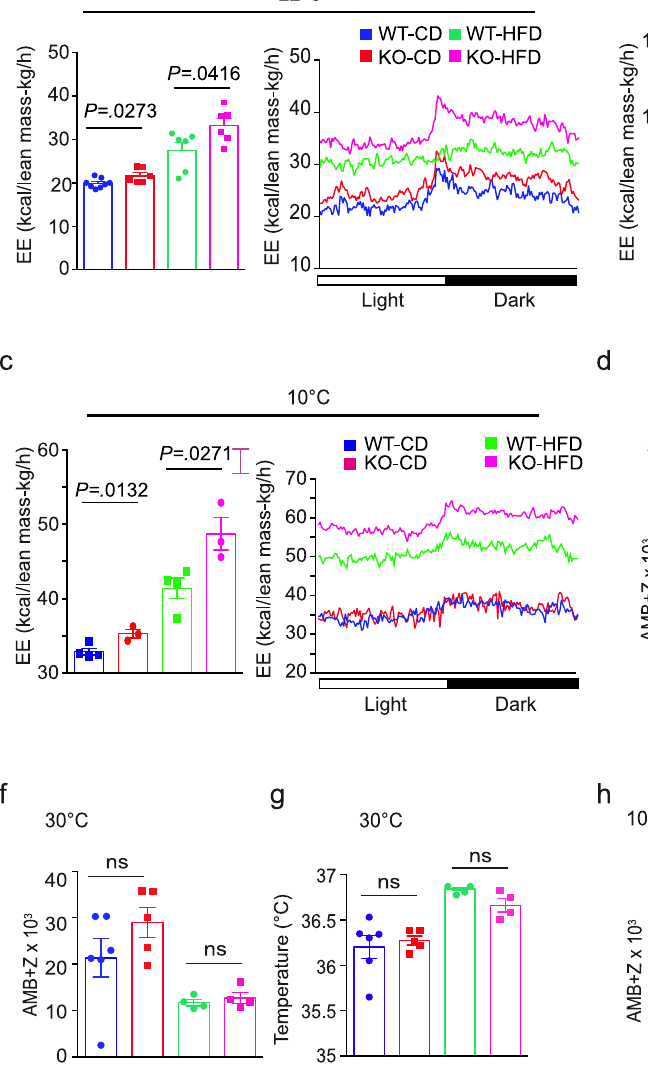
Fig. 2 | Mice lacking AIF1 expend more energy in both ambient and thermo- neutral conditions, independent of changes in activity or temperature. Meta- bolic characteristics of AIF1-de fi cient and control mice fed with CD or HFD for 16 weeks were measured using metabolic cages atambient temperature (22°C), at thermoneutrality (30°C), oratreduced temperature(10°C). a Energy expenditure (EE)at22°C,showingmeanvaluescollectedover4days(leftpanel)andovera24h light-dark cycle (right panel) ( n : WT-CD, 8; KO-CD, 6; WT-HFD, 6; KO-HFD, 6). b , c Similarassessments,butwithmicehousedat30°C( b )( n :WT-CD,6;KO-CD,5; WT-HFD,4;KO-HFD,4)or10°C( c )( n :WT-CD,4;KO-CD,3;WT-HFD,4;KO-HFD,3). d Physical activity measured by beam breaks, or e temperature, showing mean a role for peripheral 5-HT in the obesity resistance phenotype. On the other hand, we found increased NE content in both BAT and iWAT of AIF1-de fi cient mice fed a CD, while with HFD, the corresponding NE levels decreased in WT mice, but were relatively higher in AIF1- de fi cient mice(Fig. 3a,SupplementaryFig. 6d). NE levels in liver,heart, and serum were not changed by AIF1 de fi ciency (Fig. 3b,c) and serum levels of homovanillic acid (HVA), a major catecholamine metabolite, were also not different (Supplementary Fig. 6e). Taken together, these fi ndings suggest that loss of AIF1 increases catecholamine levels dis- cretely in tissues with thermogenic capability.